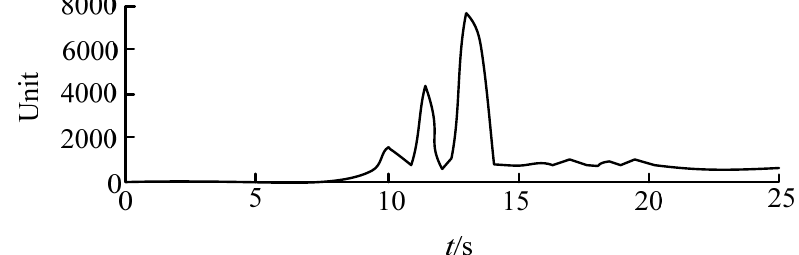
Figure 6: Time-history curves of 3rd plastic damage elements of global